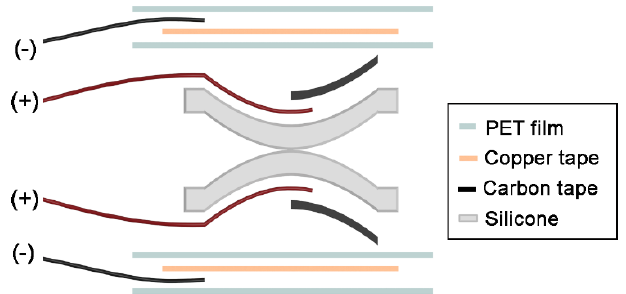
Figure 3. X-shaped actuator structure. Carbon tape attached to silicone is connected to the (+) of the input voltage and the surrounding copper tape is connected to the (-) of the input voltage to create an electrostatic force. In between, the two electrodes are blocked with polyethylene terephthalate (PET) films.